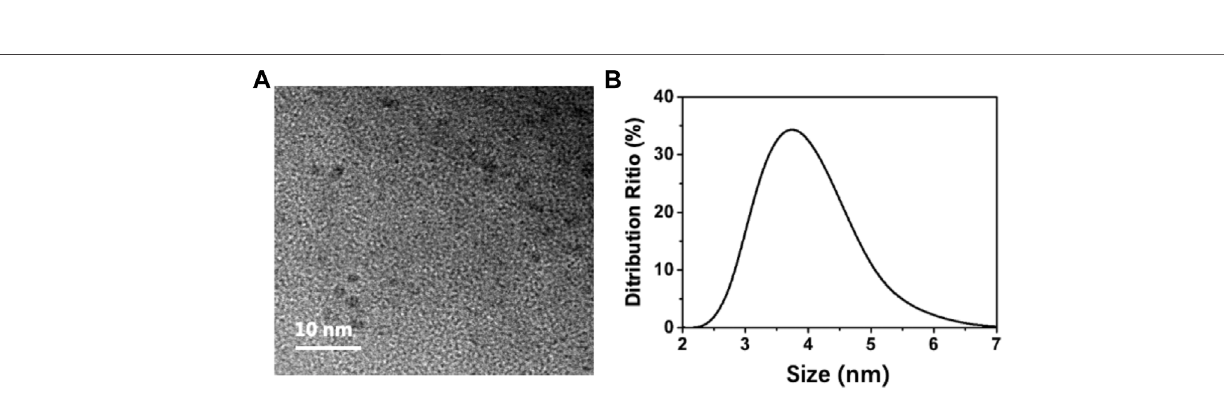
FIGURE 2 | Morphology of BAPTCDs. (A) TEM image of BAPTCDs (scale bar: 10 nm). (B) Dynamic light-scattering detection of BAPTCDs.